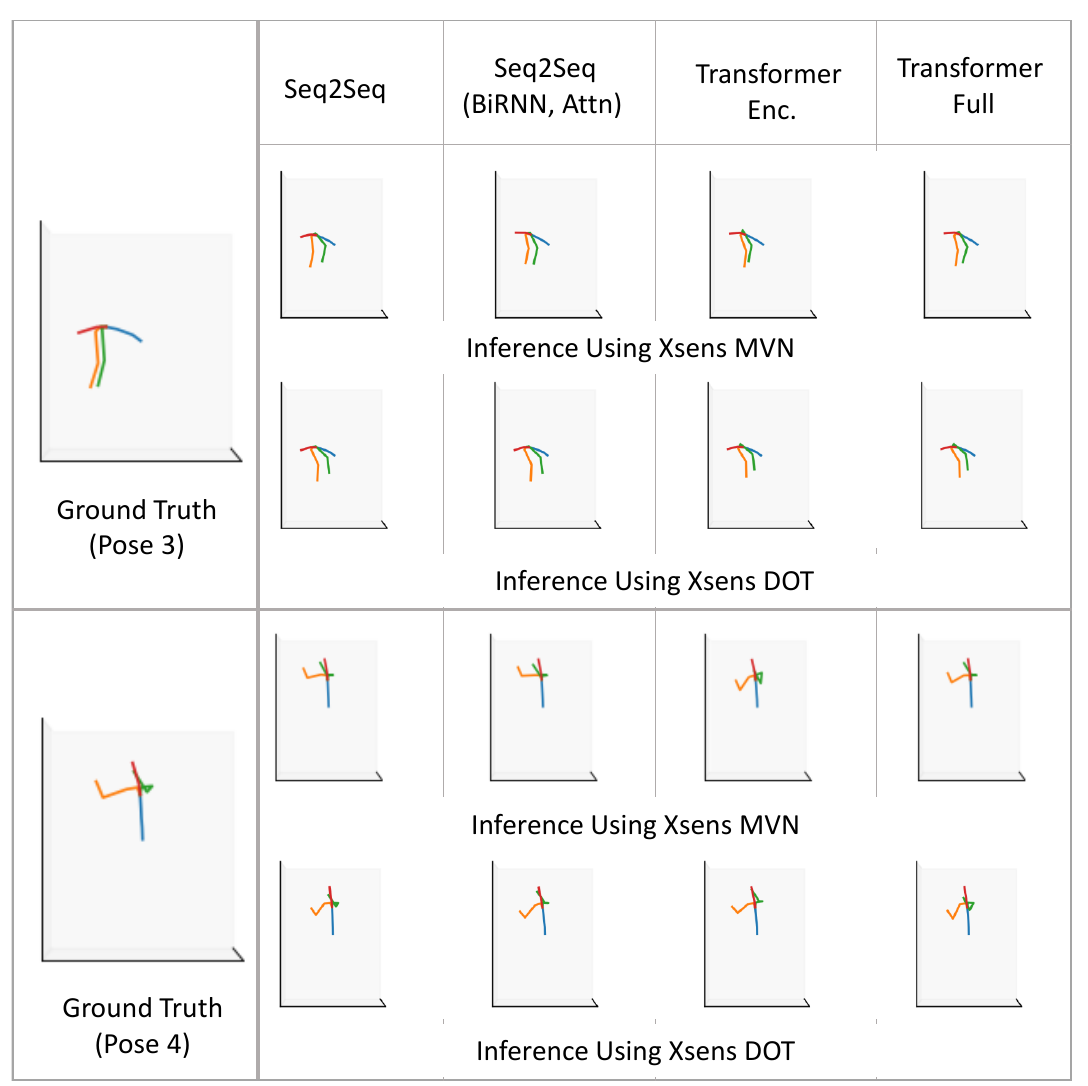
Figure 25. Qualitative evaluation is presented for challenging human poses while standing (Pose 4) and sitting (Pose 3). These poses are relatively challenging for inference since the person uses many hand or body